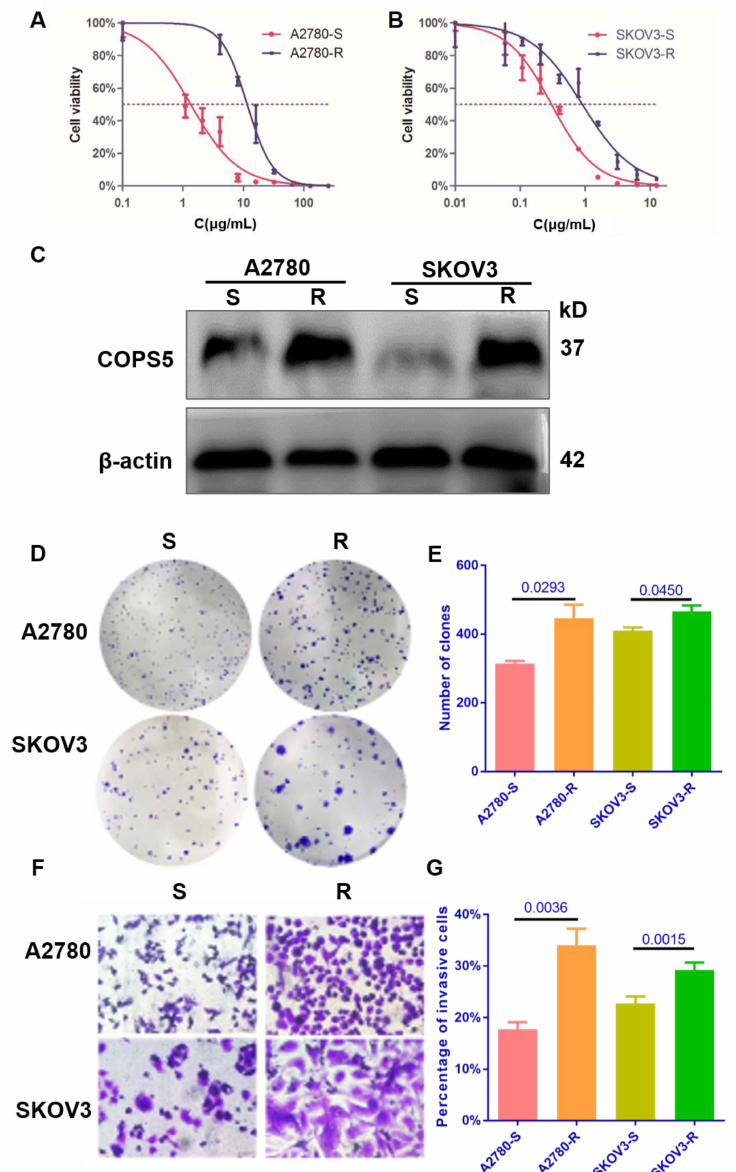
Figure 2. The proliferation and migration of ovarian cancer cell lines were enhanced after platinum resistance. The platinum sensitivity of cell lines ( A , B ). The expression of COPS5 in platinum-resistant ovarian cancer cell lines ( C ). The colony formation ability of platinum-resistant cell lines ( D , E ). The migration ability of platinum-resistant cell lines (400 × ) ( F , G ). All experiments were carried out in triplicate. A2780-S, platinum-sensitive A2780; A2780-R: platinum-resistant A2780; SKOV3-S, platinum-sensitive SKOV3; SKOV3-R, platinum-resistant